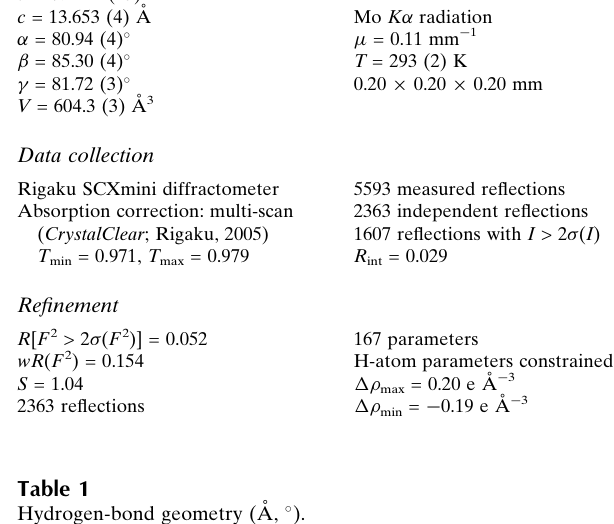
Rigaku SCXmini diffractometer Absorption correction: multi-scan